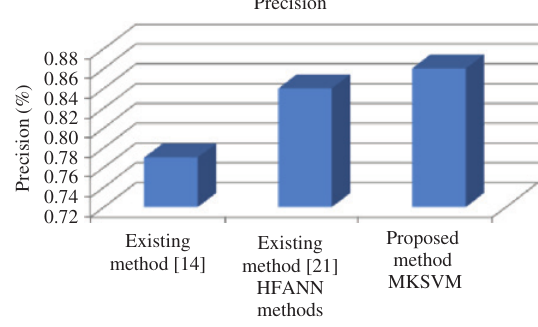
Figure 8: Comparative Analysis of Precision.